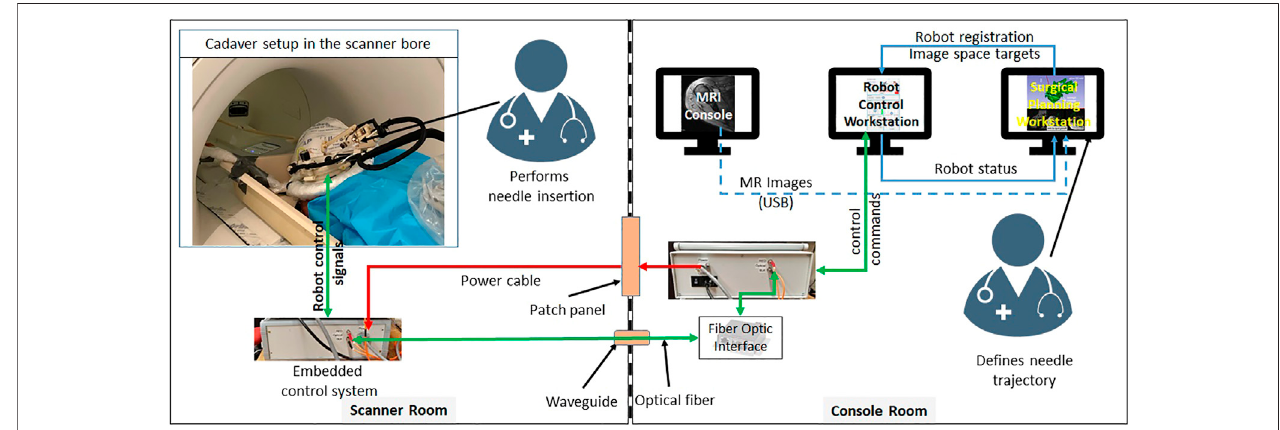
FIGURE 1 | System block diagram showing all the components, their layout in the MRI facility and the data fl ow between them.